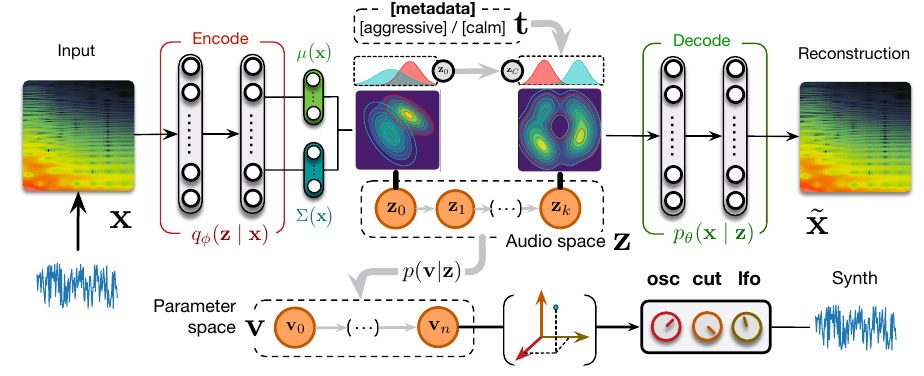
Figure 2. Universal synthesizer control . We learn an organized latent audio space z of a synthesizer capabilities with a Variational Auto-Encoder (VAE) parameterized with Normalizing Flow (NF). This space maps to the parameter space v through our proposed regression flow and can be further organized with metadata targets t . This provides sampling and invertible mapping between different